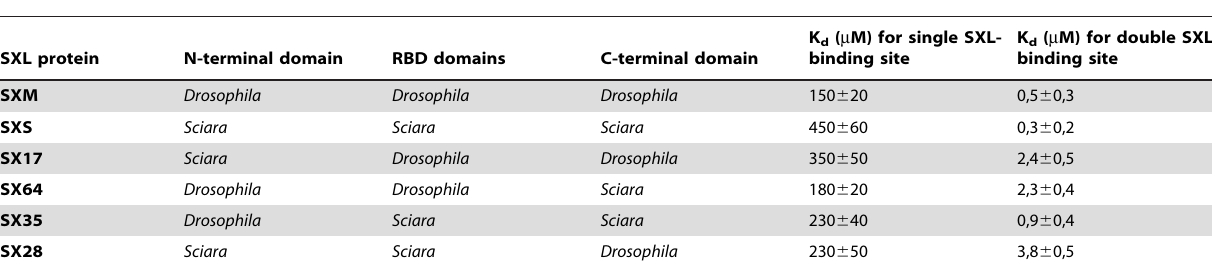
Table 1. Binding of the chimeric SXL proteins to Drosophila SXL-binding